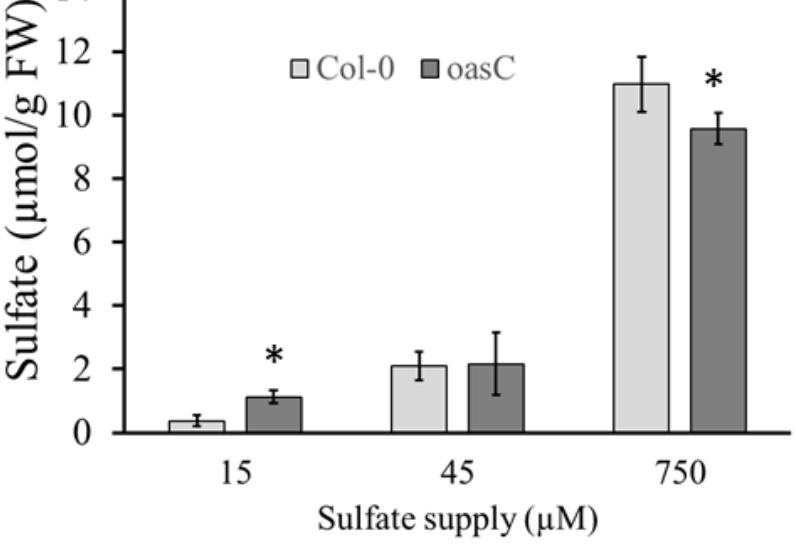
Figure 5. Exogenous sulfate supply affects sulfate levels in oasC mutant. Col-0 and oasC were grown on MS-agarose plates containing 15 µM, 45 µM, and 750 µM sulfate. Sulfate levels of the leaves were measured. Data are presented as means ± S.D. from four biological replicates. Asterisks mark values significantly different from the wild-type Col-0 at p < 0.05 (Student’s t -test).